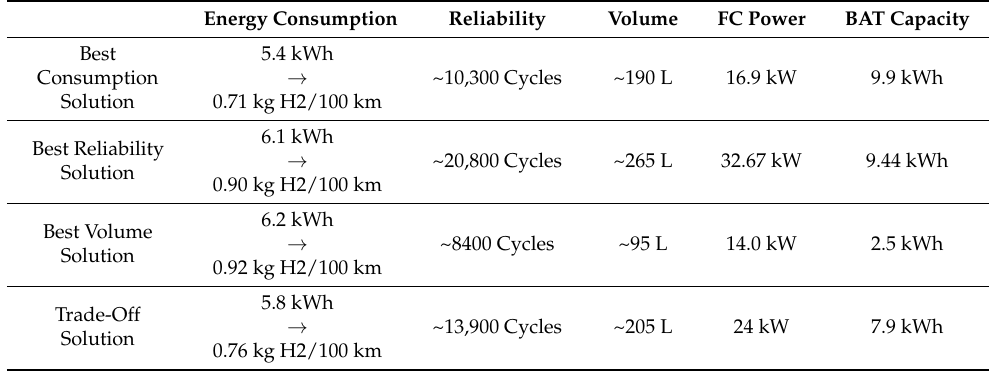
Figure 15. Design mapping on US 06 Cycle. Table 2. WLTC design